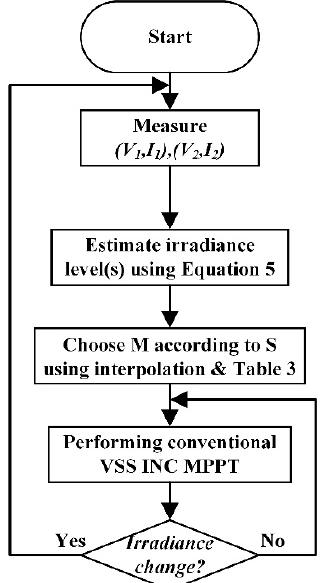
Figure 3. Flow chart of the proposed method. VSS: Variable Step Size; INC: Incremental Conductance; MPPT: Maximum Power Point Tracking.